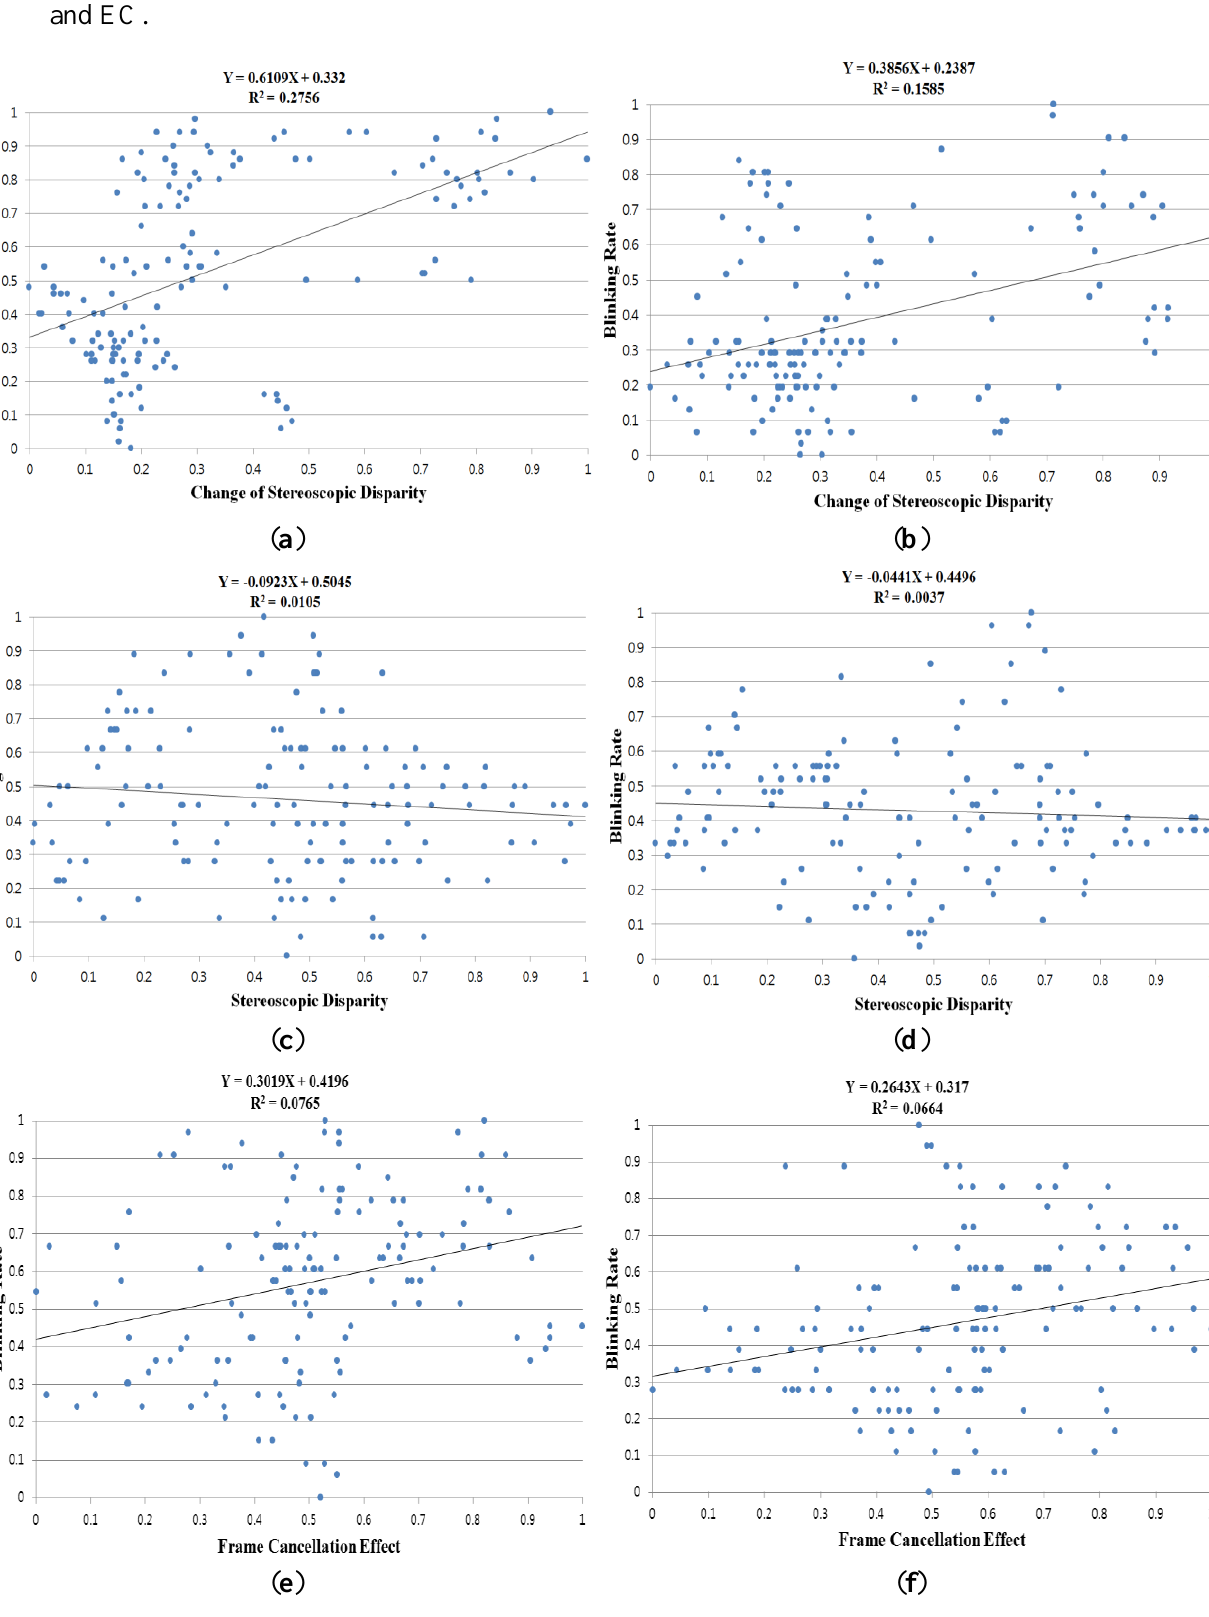
Figure 6. Linear regression results: regression lines showing the correlation ( a , b ) between BR and CSD; ( c , d ) between BR and SD; ( e , f ) between BR and FCE; ( g , h ) between BR and